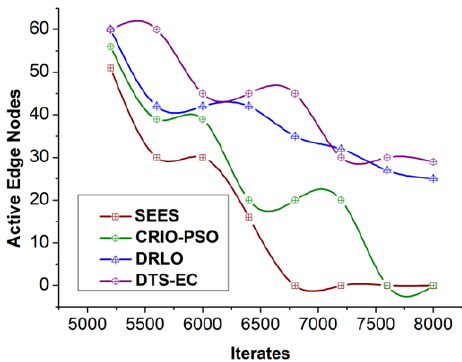
Figure 7. Comparisons between the results of active edge nodes for the methods in this study. In Equation (12), Ie n denotes the initial energy of the IoT-edge node. The node exploits energy for data dissemination and queuing